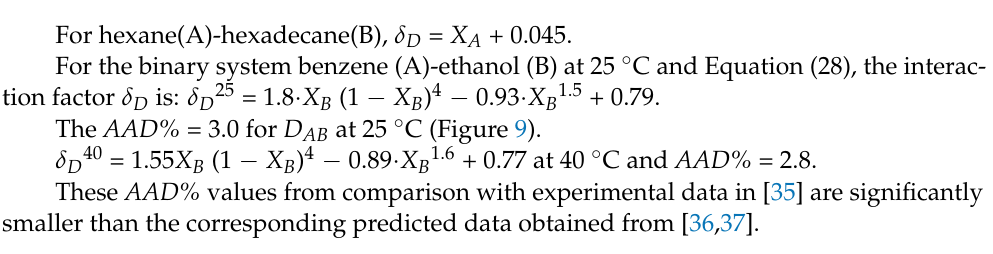
Figure 8. Diffusion coefficients D AB in a binary system hexane (A) ‐ hexadecane (B) at 25 °C with experimental points ( • ) [35] and calculated ( ▬ ) with Equation (28).